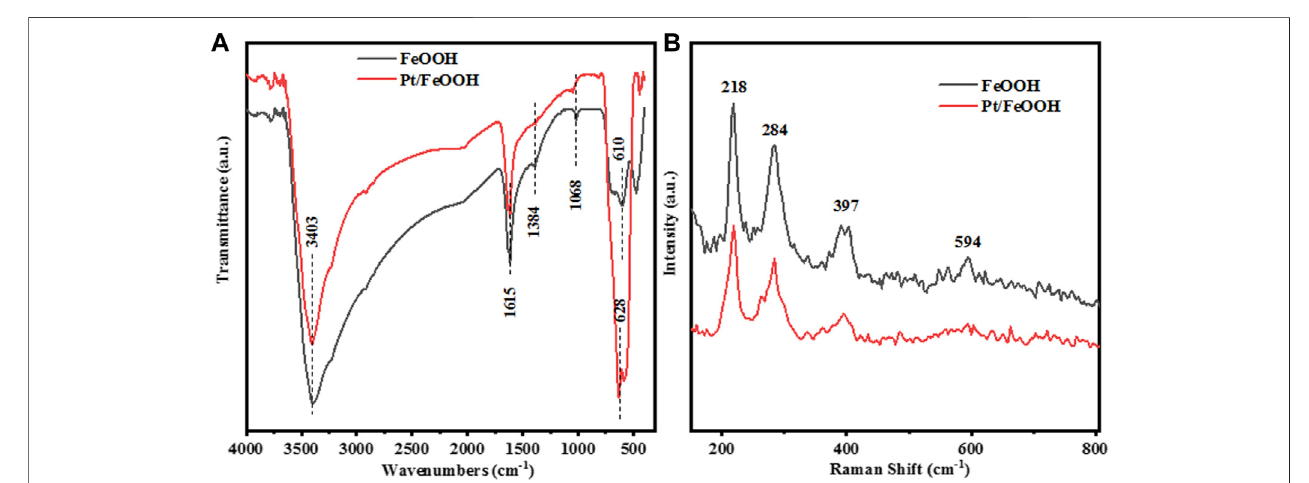
FIGURE 3 | (A) FT-IR spectra and (B) Raman spectra of